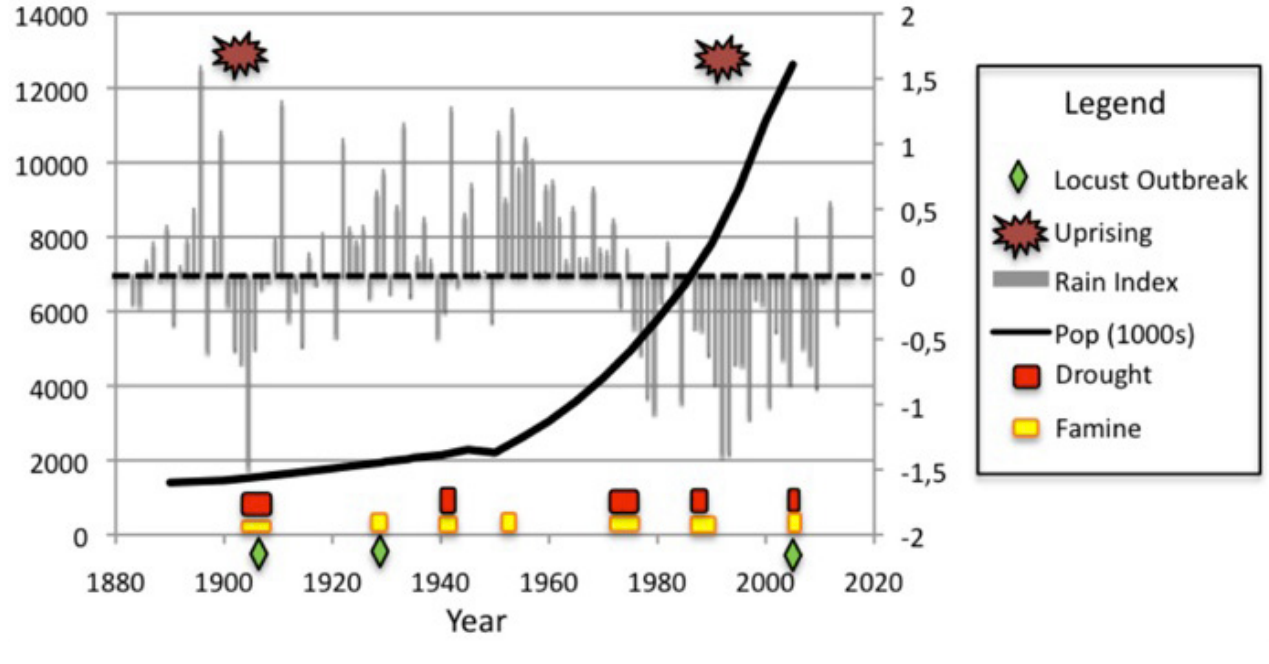
Fig. 2 . Outbreaks of locusts, drought, and famine against the background of historical trends for population and rainfall in Niger in the twentieth century. Data sources for rainfall, from rain gauge stations across West Africa (L’Hôte et al. 200, Table 1). The “Sahelian annual rainfall index” reflects differences from the mean annual rainfall measured over the long term (1896 to 2000). Sources: Lahmeyer 2006 (population, Y-axis left side), Raynaut 1997 (drought and famine), and MacDonald 1986 (locust outbreaks data). Note: rainfall data aggregated to regional levels do not reflect more local and patchy patterns of rainfall, water scarcity, and